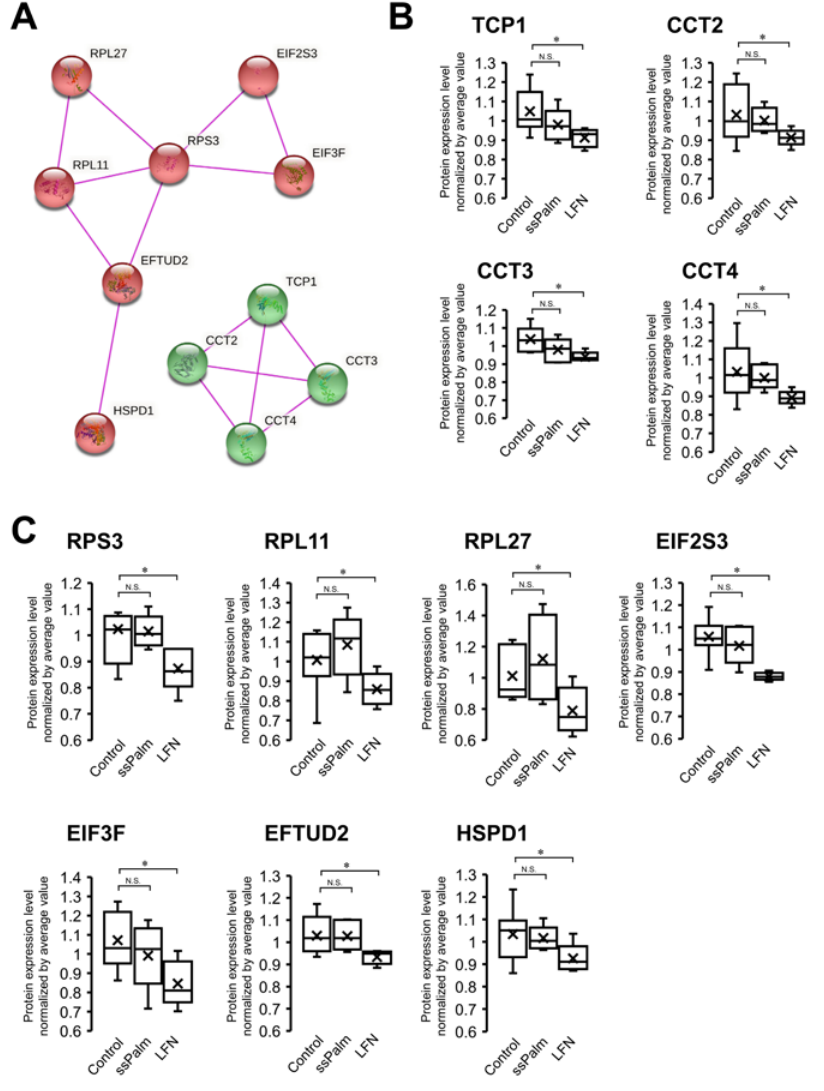
Figure 6. Top 2 clusters that are down-regulated in the LFN group but not in the ssPalm group. ( A ) 67 proteins whose expression levels were significantly changed in the LFN-treated group but not in the ssPalm-LNP-treated group (Table S2 analyzed using the STRING Database (https://string-db.org/ accessed on 2 May 2022) to visualize functional protein association networks [19] with an MCL clustering mode based exclusively on experimentally determined interactions. For the top 2 clusters, the interaction maps obtained on the String website are shown in this figure. The first cluster consists of translation-related proteins (red-colored nodes), and the second cluster consists of chaperonin- containing TCP-1 (CCT) proteins (green-colored nodes). ( B , C ) the levels of expression of CCT ( B ) and translation-related proteins ( C ) were compared among the control, ssPalm-LNP-treated group, and LFN-treated groups ( n = 5–9). The band inside the box represents the median, and the bottom and top of the box indicate the first and third quartiles, respectively. Whiskers indicate the minimum and maximum values of the protein levels. X plots show the average in each group. * the Benjamini– Hochberg adjusted p value < 0.05 was significantly down-regulated compared to control